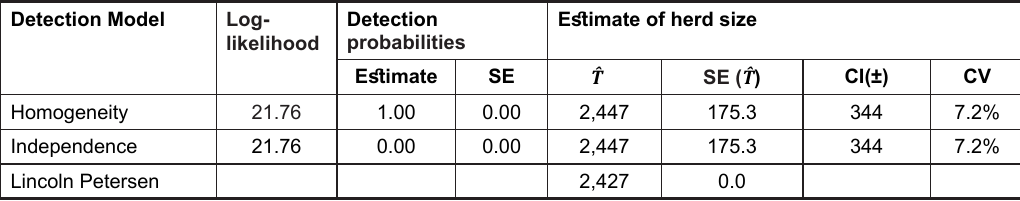
Table 32. Rivest model estimates and LP estimate for Cape Bathurst 2012 post calving